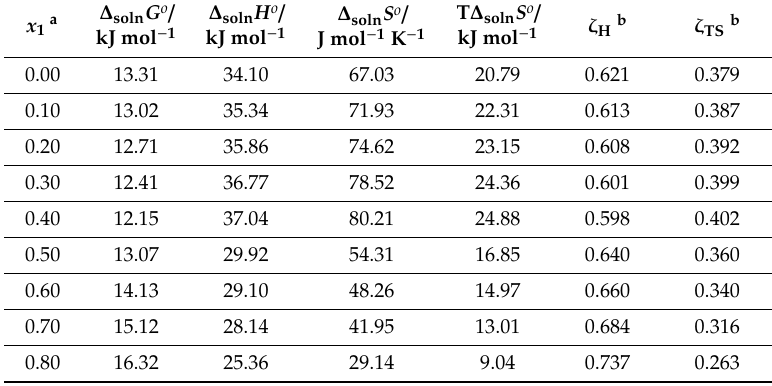
Table 3. Thermodynamic functions of dissolution processes of amygdalin in {ethanol (1) + water (2)} cosolvent mixtures at T hm = 310.22